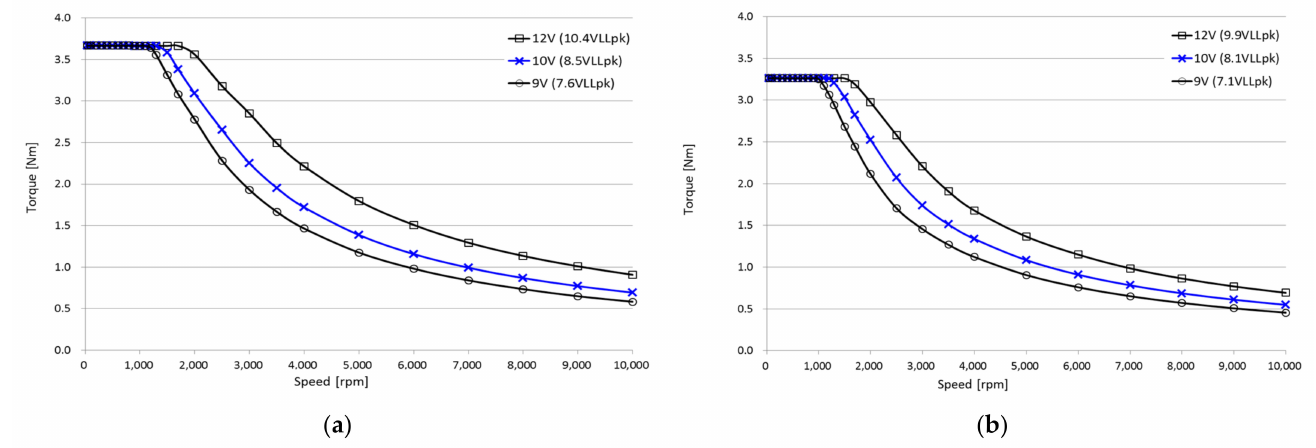
Figure 14. Torque speed characteristics: ( a ) 20 °C; ( b ) 125 °C.